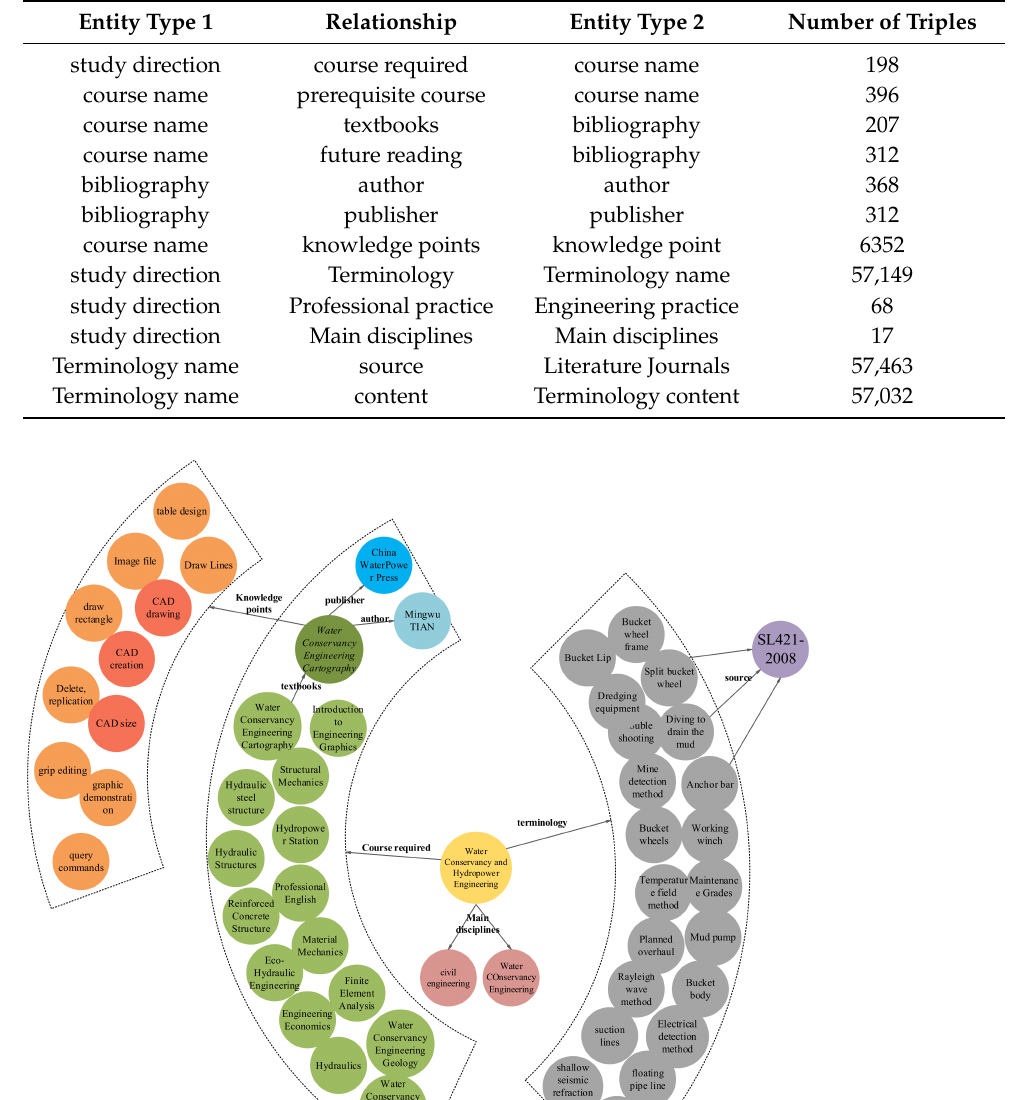
Table 2. Entity-relationship Extraction Results.